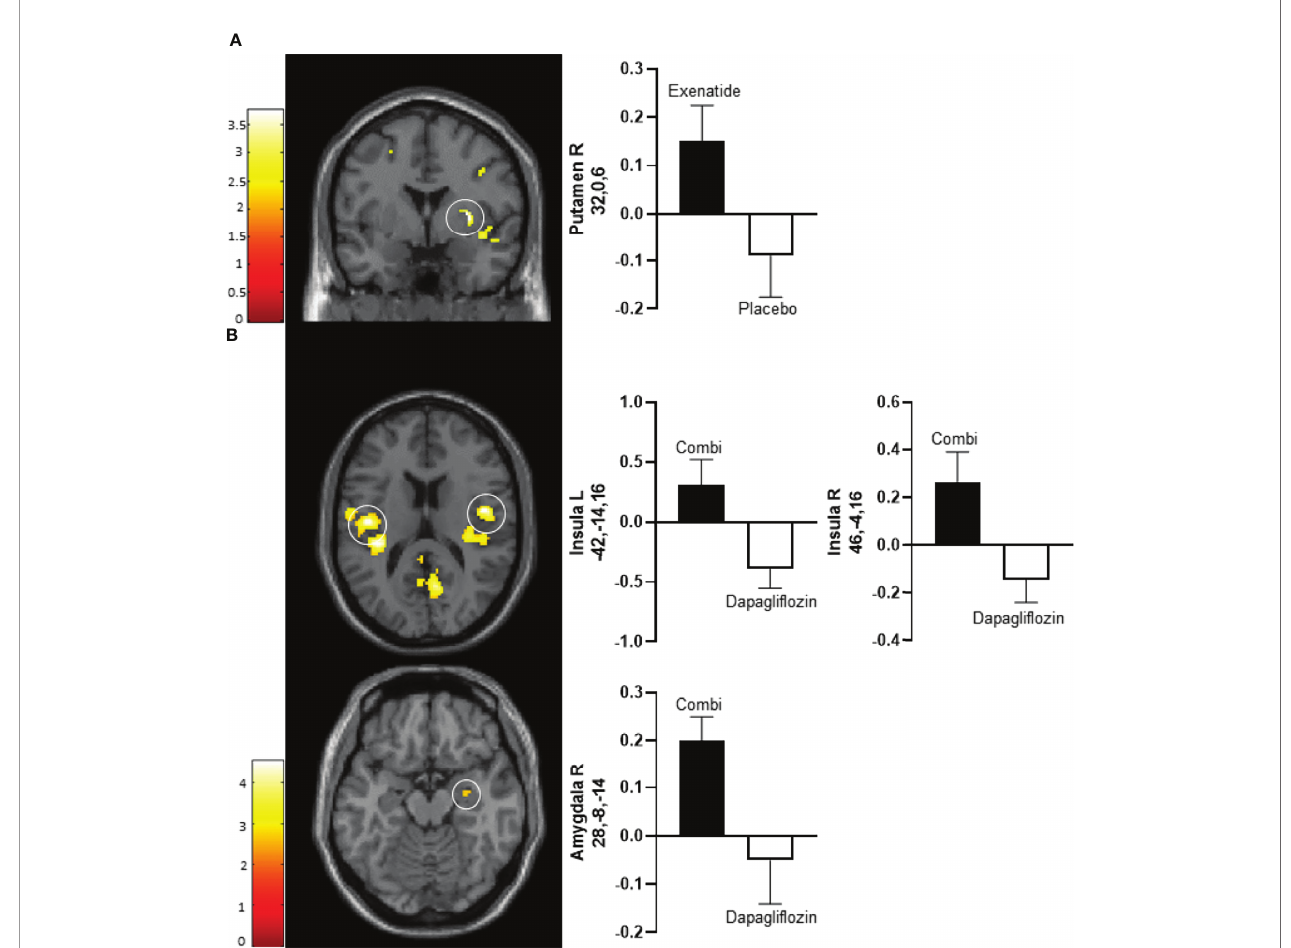
FIGURE 2 | Average differences in CNS activation after 10 days of treatment. (A) Axial slice showing average differences between exenatide (black bar) and placebo (white bar) in the right putamen ( P FWE < 0.01, T=3.2) (upper panel) in response to the viewing of low-calorie versus non-food pictures. (B) Horizontal slice showing average differences between dapagli fl ozin plus exenatide (combi) (black bar) and dapagli fl ozin (white bar) in the left insula ( P FWE < 0.01, T = 4.3) (middle left panel), right insula ( P FWE < 0.01, T = 4.3) (middle right panel), and right amygdala ( P FWE < 0.05, T = 2.8) (bottom panel) in response to the viewing of low-calorie food pictures versus non-food pictures. The left side of the brain slices is the left side of the brain. The color scale re fl ects the T value of the functional activity. Results are presented at the threshold of P < 0.05, familywise error (FWE) corrected on cluster extent within the regions of interest using small volume correction (10 mm sphere; 5 mm sphere for the amygdala). In the graphs, blood oxygen level-dependent (BOLD) signal intensity (effect size) is plotted (arbitrary unites), mean and SEM. The numbers on the y-axes of the bar graphs are the x,y,z, coordinates of the peak voxel of the observed difference in Montreal Neurological Institute (MNI) space. Combi, dapagli fl ozin plus exenatide; R, right; L,